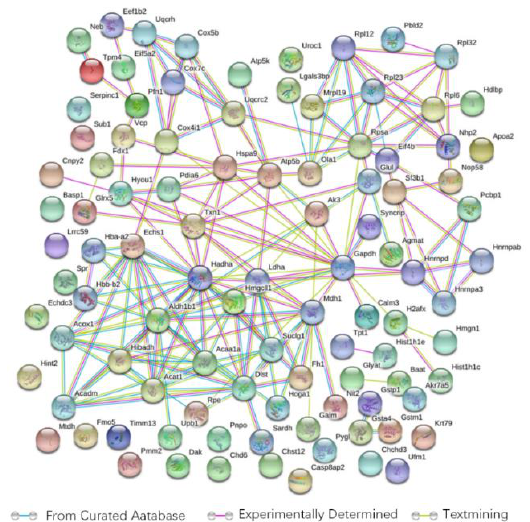
Figure 5. The signaling pathway of betaine affecting the liver protein profile of mice on an HF diet analyzed by the STRING database. Green lines: curated databases, purple lines: experimentally determined, yellow lines: